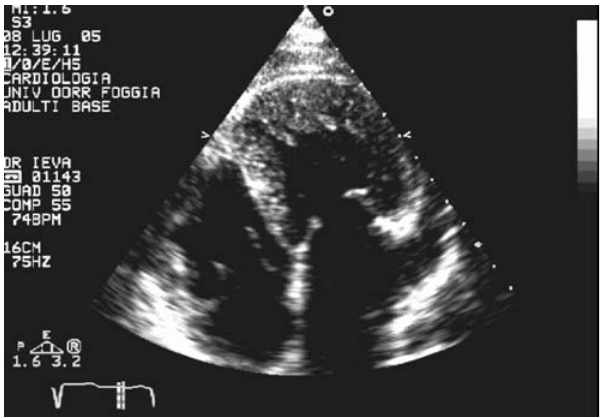
Figure 2 - Apical four-chamber view shows dilatation of both the left atrium and left appendage and a smooth interventricular septalright surface against the trabeculatedseptal left surface in the correct position(normal atrial situs). This permits diagnosis of ventricular inversion and the presence of a three- leaflet tricuspid valve inserted more apically than the mitral